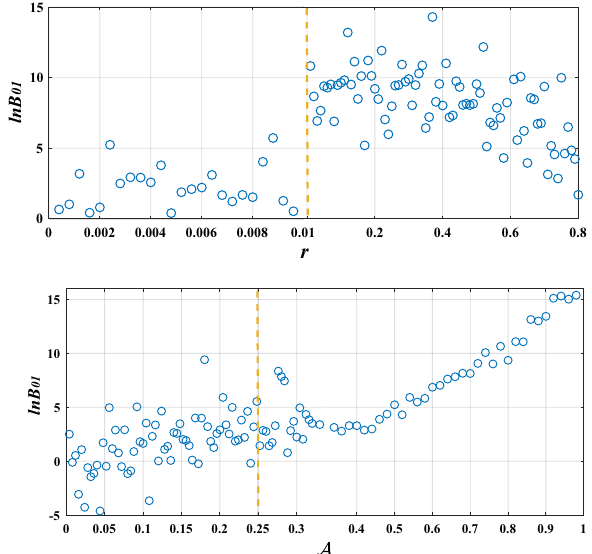
Fig. 3 The two panels are distributions of ln B 01 for different r (with A = 0 . 6) and A (with r = 0 . 15) respectively. The other parameters are chosen as β = 0 . 006, t echo = 0 . 0295, and (cid:3) t echo = 0 . 0295. The yellow dashed lines in both panels are the thresholds of r and A where the Bayes factor can be used to select the UIE model significance increases as r increases. Particularly, the UIE template is favored by 3 σ when r > 0 . 1, which indicates that the UIE template is necessary in this case. We can